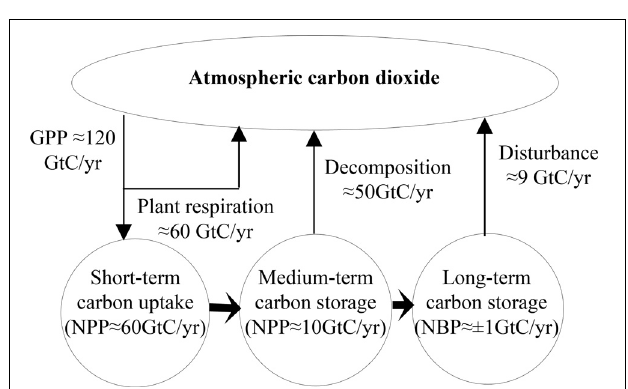
FIGURE 3 | The flow-chart of the carbon fluxes interplay in the system atmosphere-plant-soil with the grass and forest ecosystems.